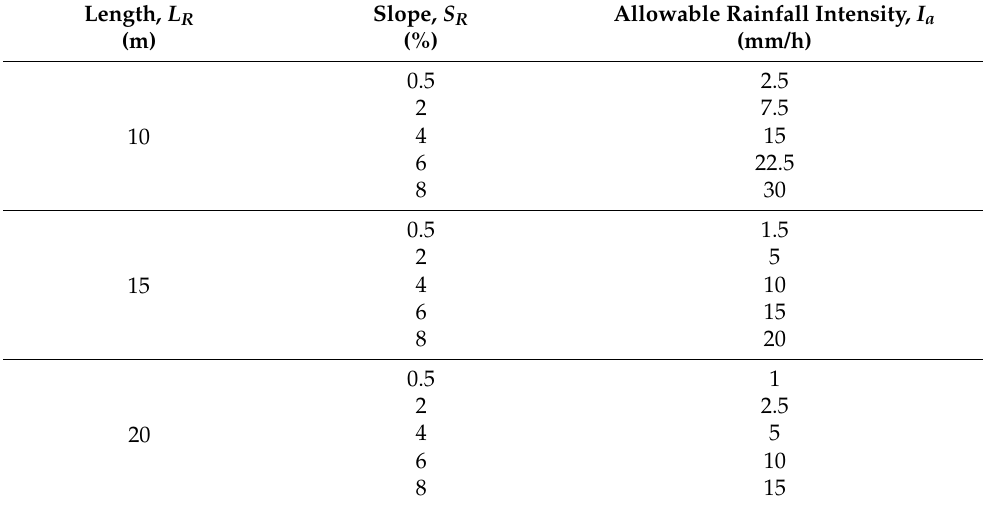
Table 4. Allowable rainfall intensity, I a